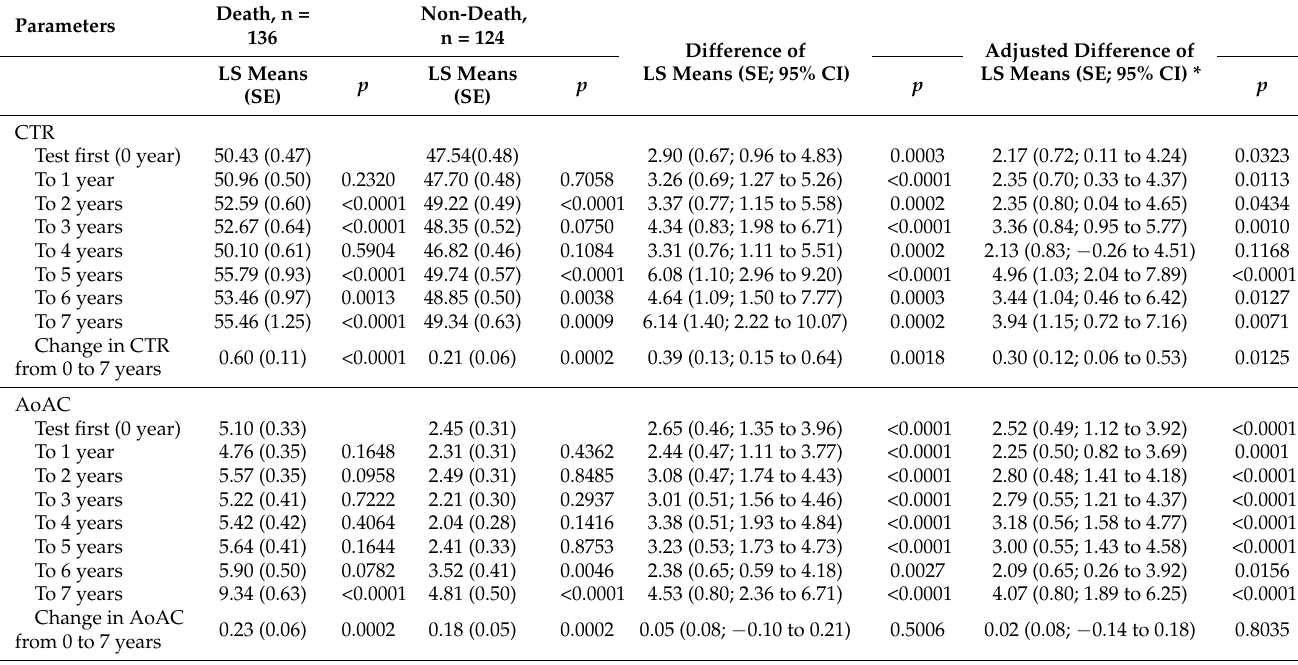
non-death groups showed 0.30 (95% CI, 0.06 to 0.53; p = 0.0125) for CTR. Table 5. Time course of mean change in CTR or AoAC from baseline (0 year) to 7 years in the death and non-death groups.